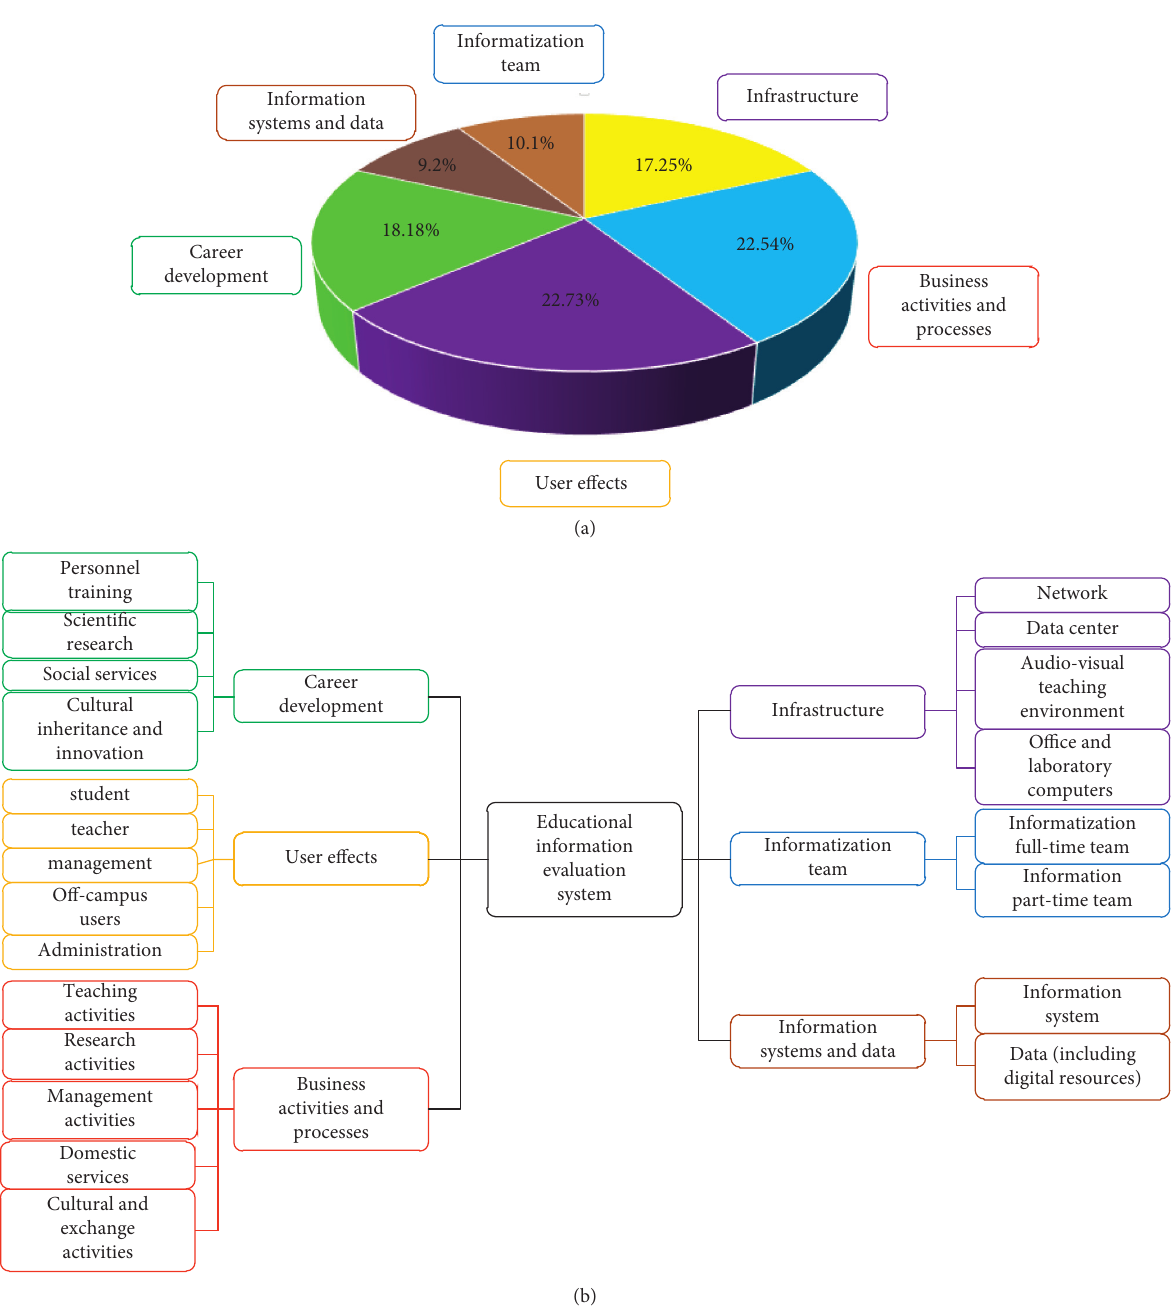
Figure 3: Performance evaluation indicators of education informatization: (a) proportion; (b)